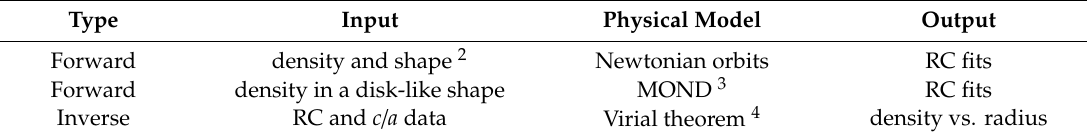
Table 2. Comparison of forward and inverse approaches to RC analysis. 1